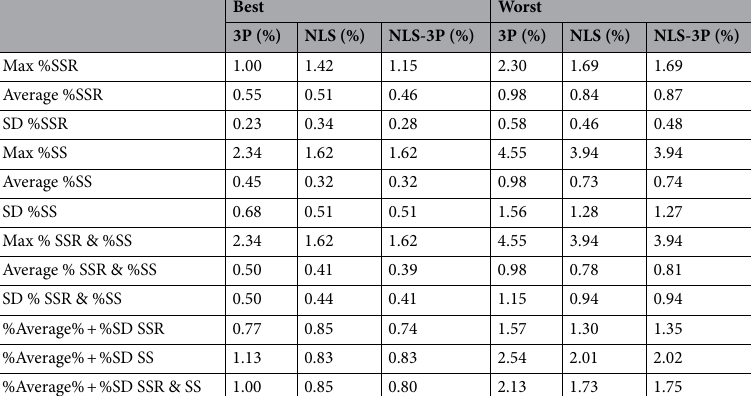
Table 5. Maximum error, average and standard deviation (SD) of the residuals obtained for the two methods of calculating them (SSR and SS) after the fitting of the data with the three different methods of fitting (3P, NLS and